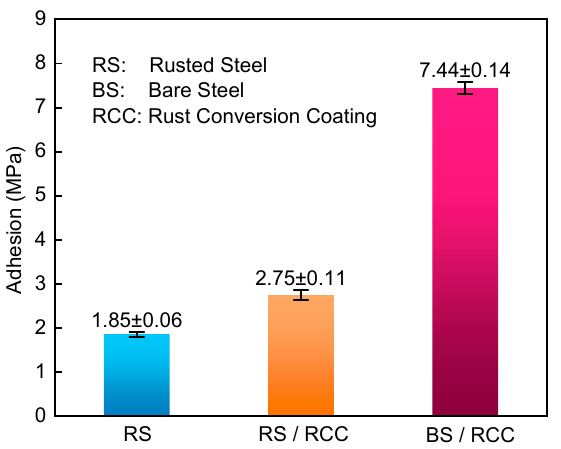
Figure 6. Fracture surface morphologies of ( a ) RS, ( b ) RS coated with RCC, ( c ) BS coated with RCC: (1) spindle, (2) substrate (RS: rusted steel, BS: bare steel, RCC: rust conversion coating).